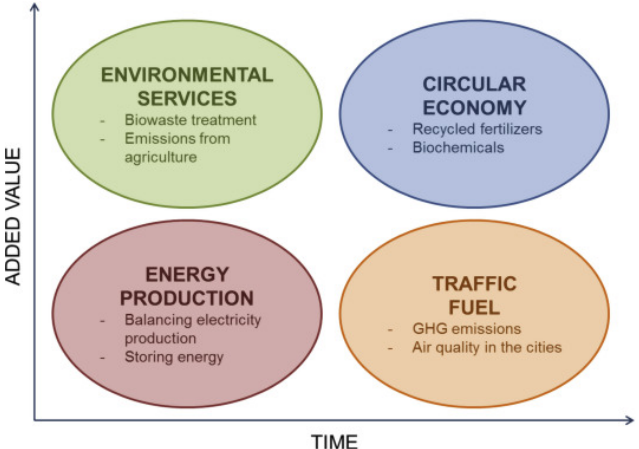
Fig. 1. Opportunities in biogas production – from energy to circular economy